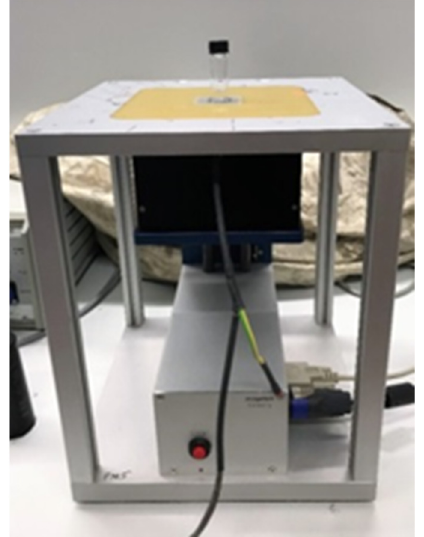
Figure 6. The experimental set-up used to measure the relaxation times of the pure solvents and their mixture before and after the solvent separation by a MOF (here UiO-66(Zr)). The sample to be investigated is simply placed on the top of the profile NMR-MOUSE.